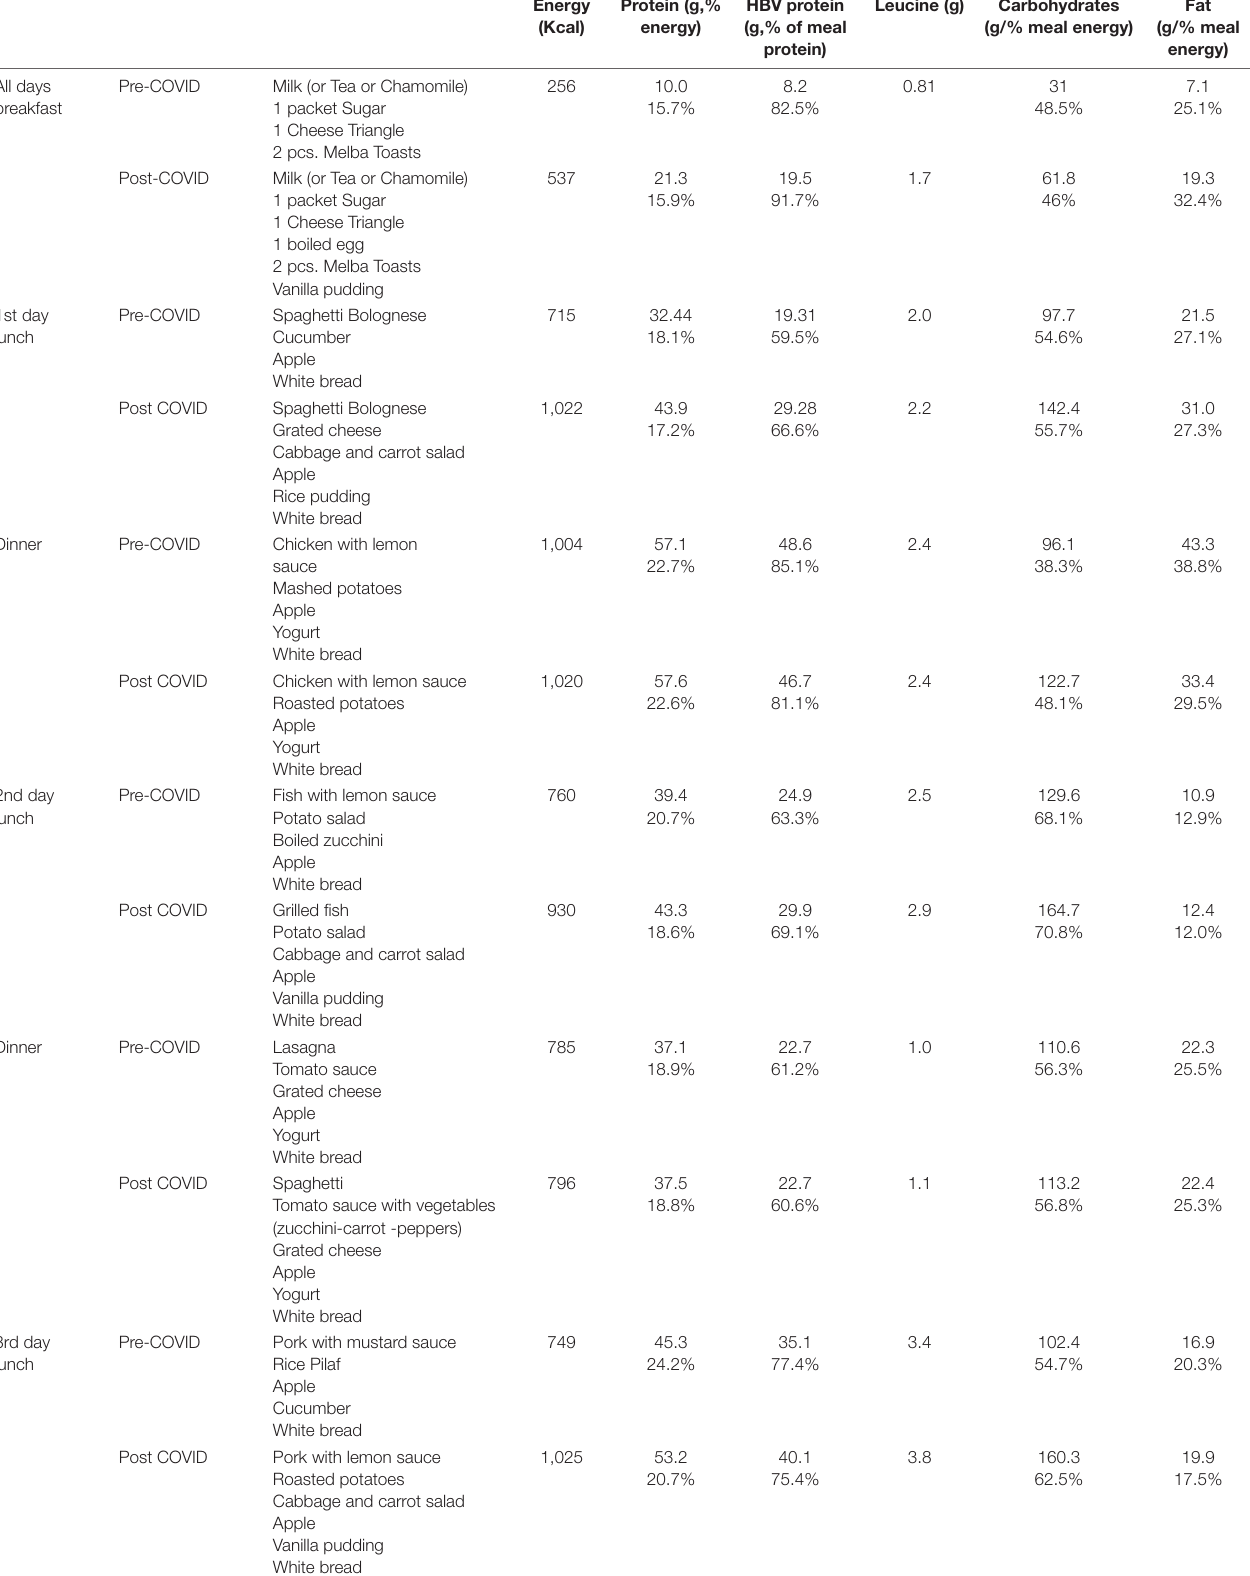
TABLE 1 | Description of the standard hospital meals and the hospital meals for COVID patients.